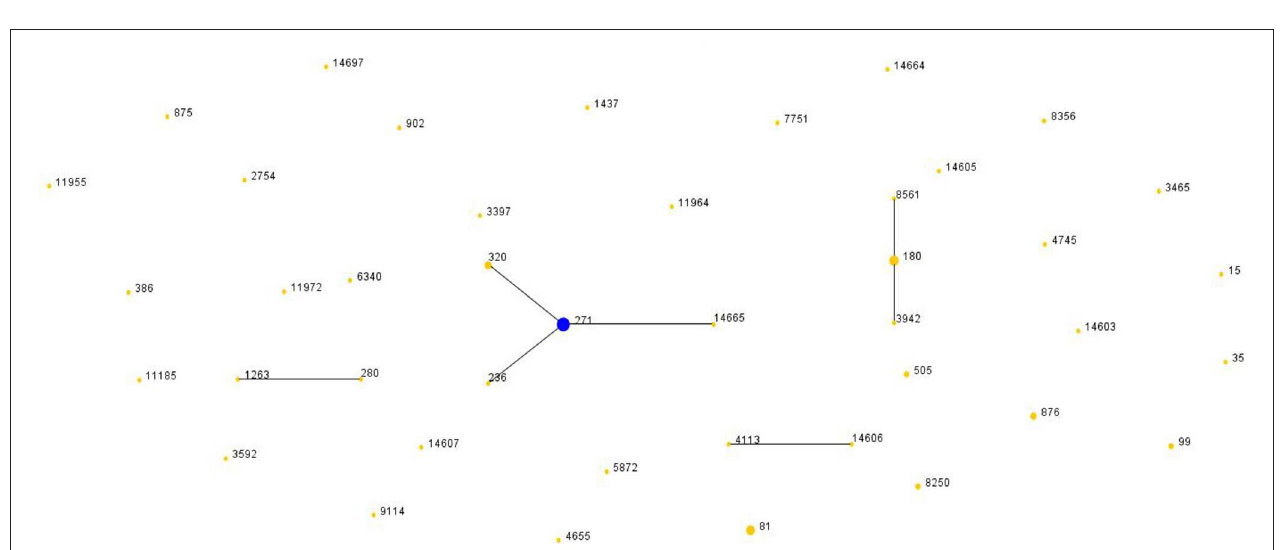
FIGURE 2 | Serotype distribution of S. pneumoniae in adults and the coverage of current vaccines in mainland of China. NT, Untypeable by multiplex-PCR.